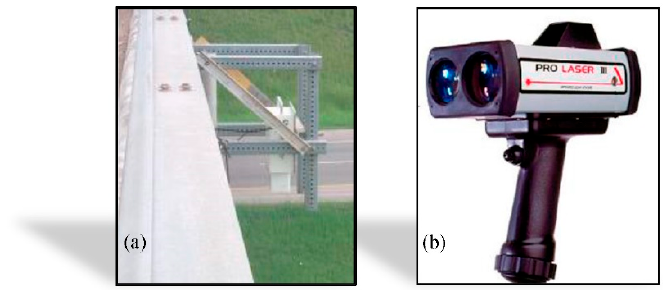
Figure 2. Laser technology. ( a ) Installation on bridges. ( b ) Laser gun.